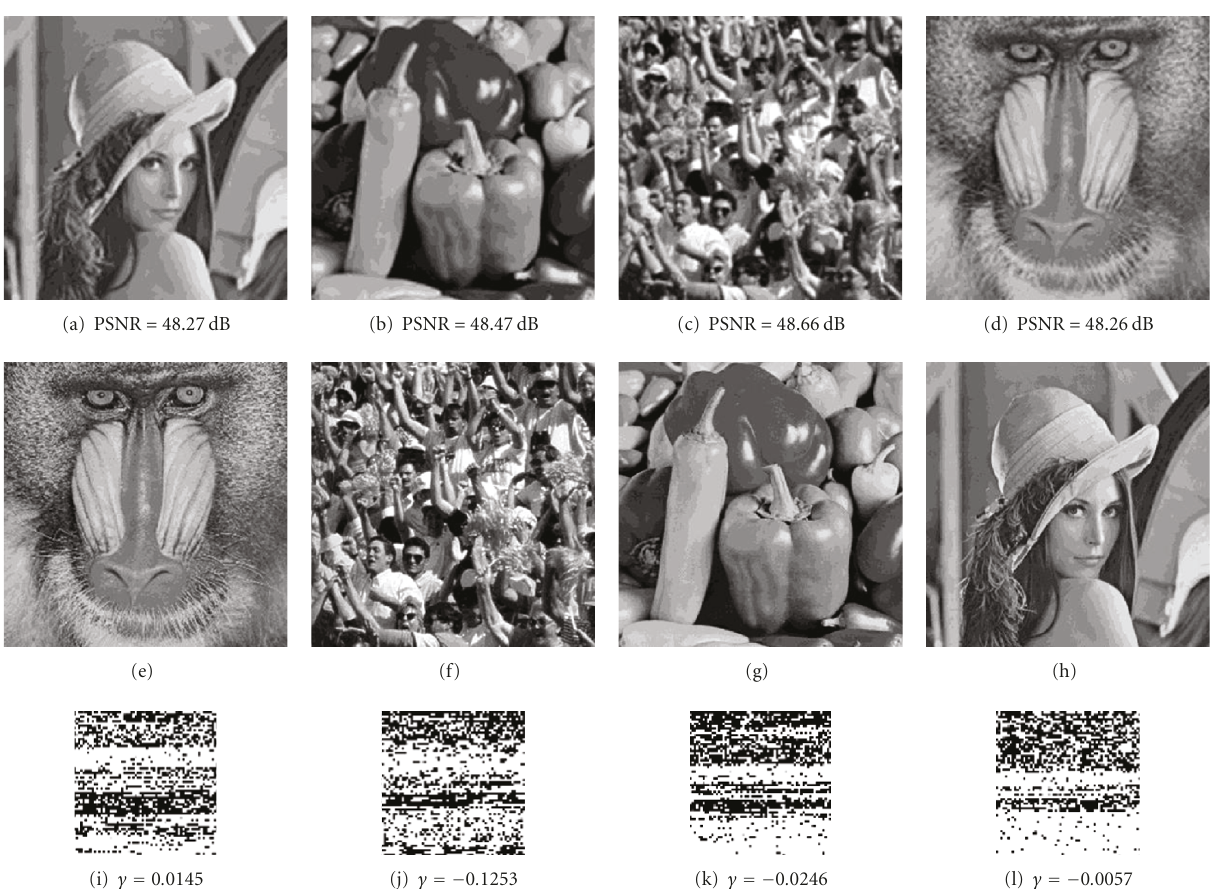
Figure 28: (a) and (b) Lena and Peppers watermarked images with 256 × 256 watermark image as shown in Figure 11(b), (e) and (f) the counterfeit watermarked image with (a) and (b), respectively. (c) and (d) The Crowd and Baboon watermarked images with 256 × 256 watermark image as shown in Figure 11(d), (g) and (h) the counterfeit watermarked image with (c) and (d), respectively. (i)–(l) the extracted watermark from (e)–(h),